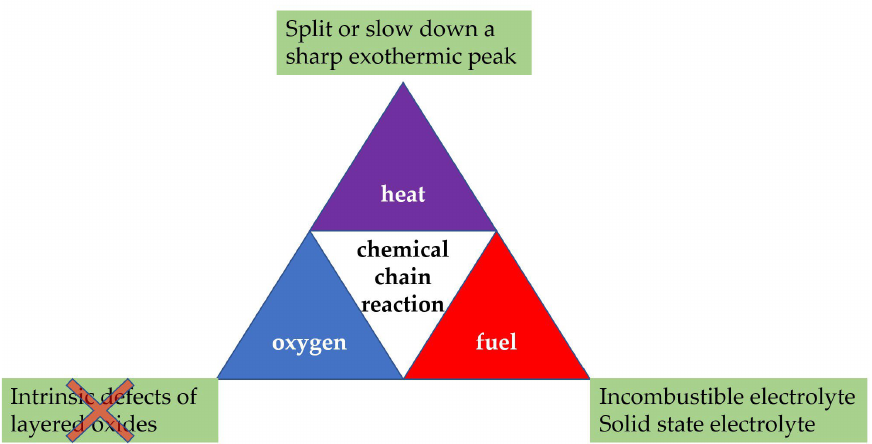
Figure 9. Scheme of the fire tetrahedron and possible corresponding strategies to improve battery safety.